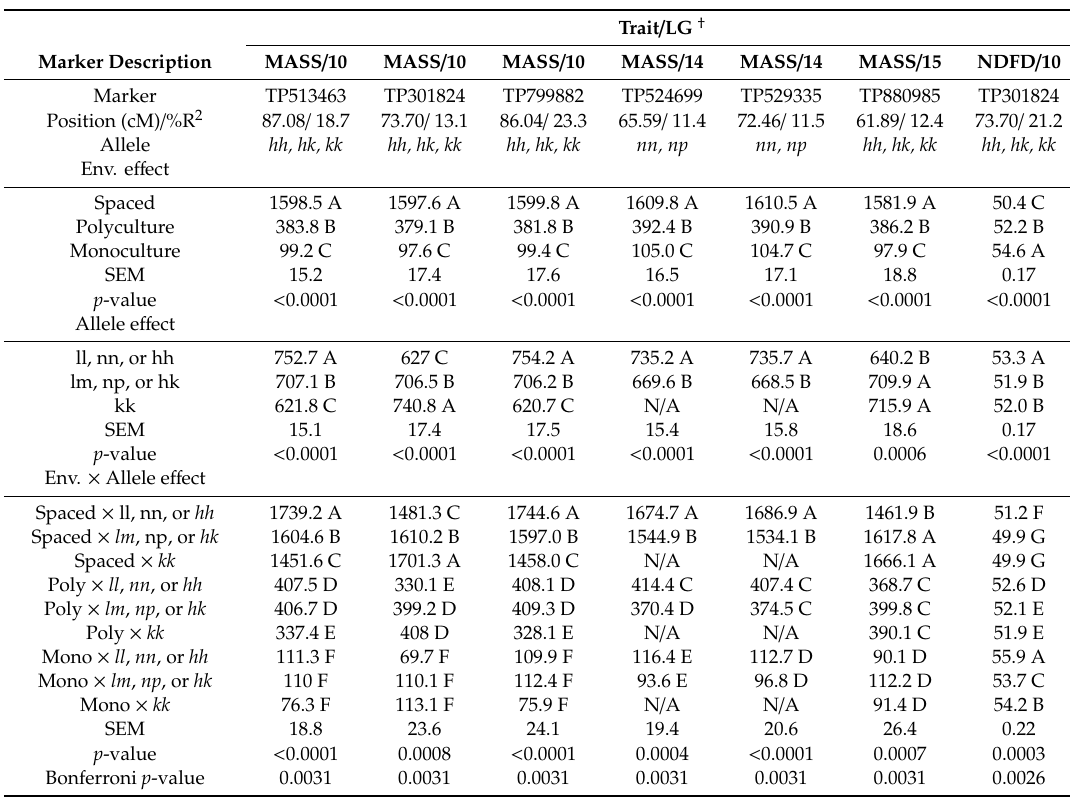
Table 5. QTL markers exhibiting significant QTL by environment interactions (Q × E). Data from 192 clonally replicated, full-sib progeny (genets) of the M26 × M35 intermediate wheatgrass mapping population evaluated in three competition environments (Spaced-Plants, Polyculture, and Monoculture) over two years (2016–2017) at Logan, UT, USA. The lm alleles are from parent M26, the np alleles are from parent M35 and the hk alleles are from both parents.